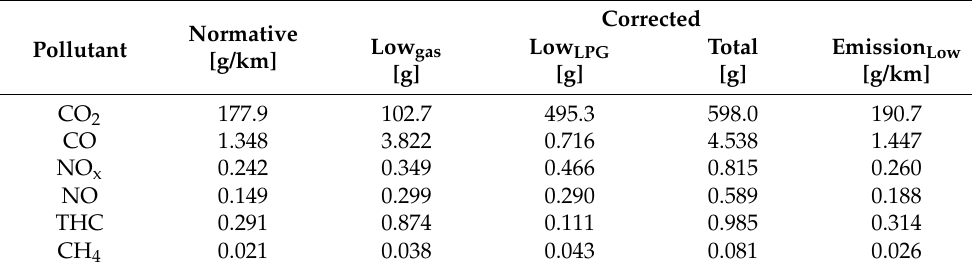
Table A2. Comparison of exhaust emissions calculated by the normative and corrected method for the Low phase of the WLTC cycle—measurement No.